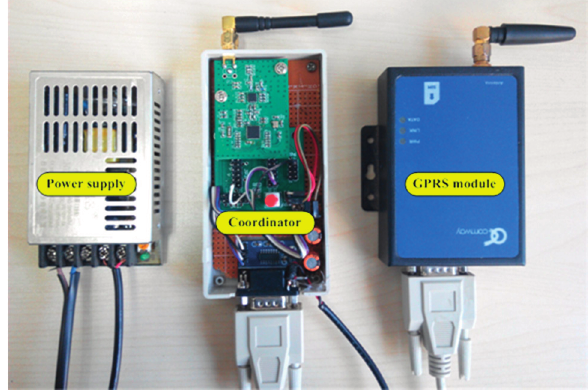
Figure 6. Physical implementation of the network coordinator (top